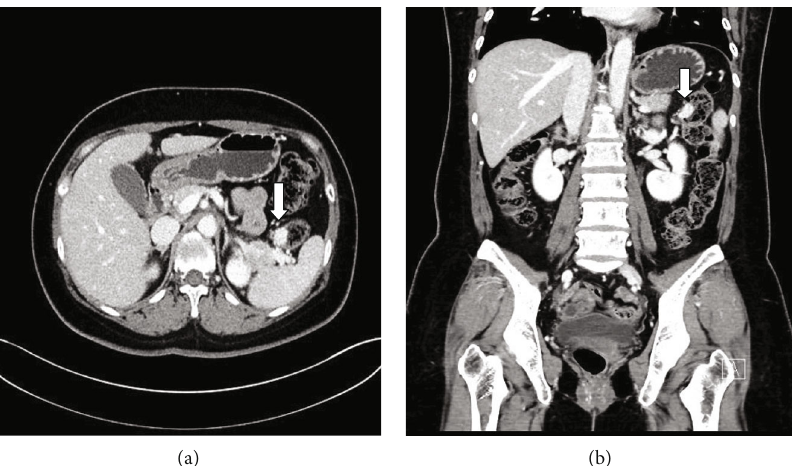
Figure 1: Radiologic fi ndings. Contrast-enhanced CT image shows a 1.6cm hypervascular tumor (arrow) in the splenic fl exure: (a) transverse view and (b) coronal